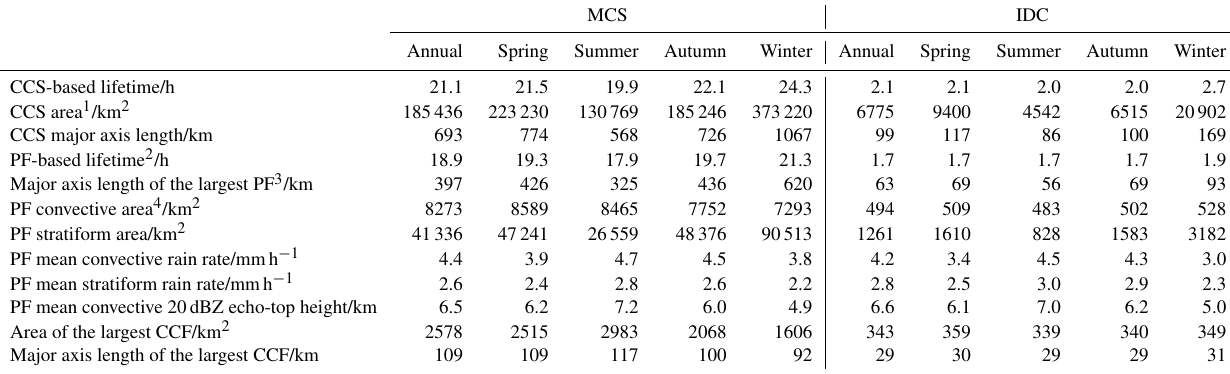
Table 1. Annual and seasonal mean characteristics of MCS and IDC events in the data product domain for